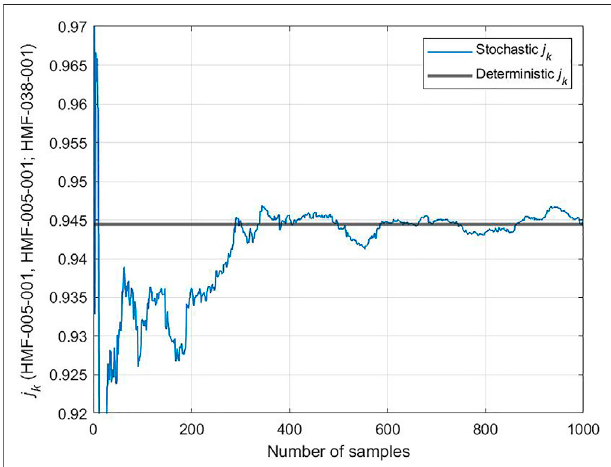
FIGURE 14 | Non-intrusive stochastic estimation of j k